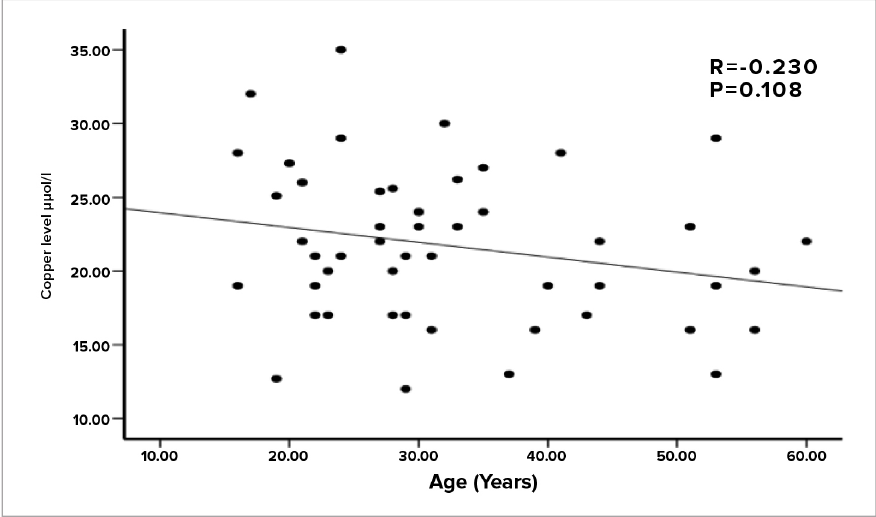
Figure 4: The Correlations Between Age and Serum Copper Level in the Study